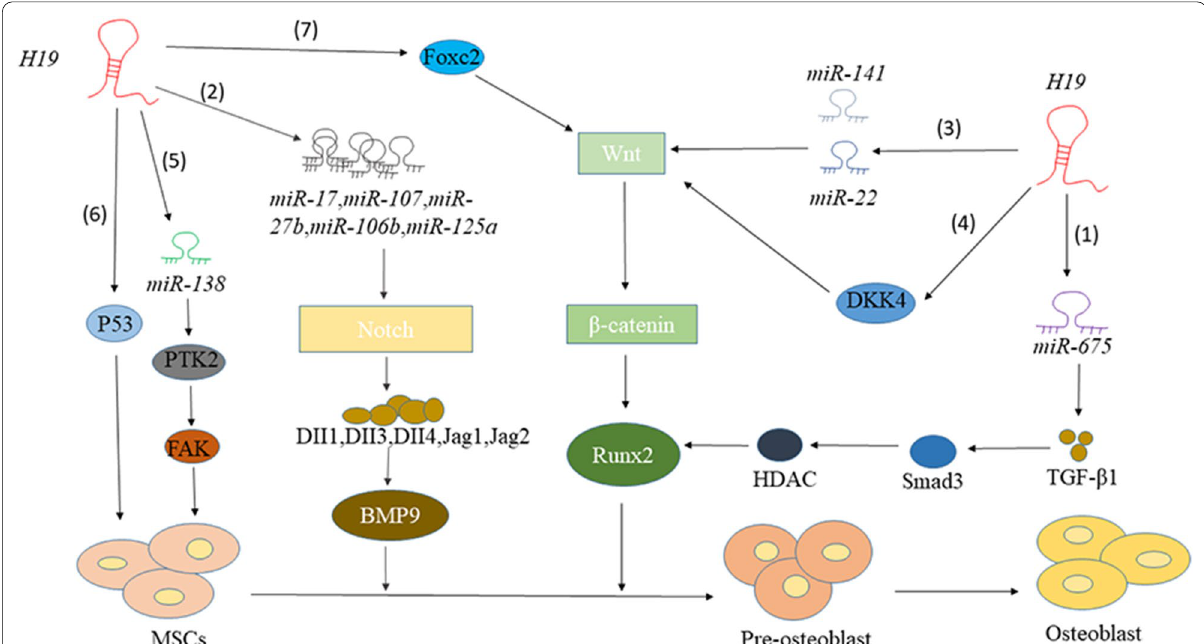
Fig. 2 Mechanism of H19 regulating osteogenic differentiation. ( 1 ) H19 Promotes osteoblast differentiation via the TGF-β1/Smad3/HDAC signaling pathway by deriving miR-675 . ( 2 ) H19 regulates the Notch signaling pathway by regulating downstream miRNA expression ligands to promote the osteogenic differentiation of MSCs induced by BMP9 ( 3 ) H19 is the miRNA sponge of miR141 and miR22 , which antagonizes the negative regulatory effects of two miRNAs on the Wnt/βcatenin pathway. ( 4 ) H19 targets DKK4 to halt its inhibitory effect on the Wnt signaling pathway and osteogenic function. ( 5 ) miR-138 sponge reduces the expression of PTK2 gene by competitively binding with H19 , promotes FAK expression, and induces osteogenic differentiation of MSCs. ( 6 ) H19 promotes the proliferation of osteoblasts by inhibiting the expression of p53. ( 7 ) The combination of H19 and Foxc2 synergistically promotes the osteogenic differentiation of bone marrow mesenchymal stem